Question: Express in one sentence what the figure is showing.
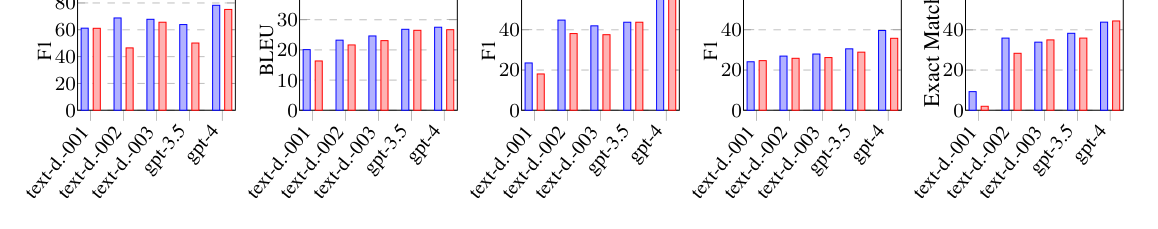
Answer: shows the results of our experiments on models of varying capability, from text-davinci- 001, -002, -003, to GPT-3.5 and GPT-4. Over- all, AMRCOT hurts performance for most tasks and models, again with Text-to-SQL being the ex- ception, at least for text-davinci-003 and GPT-4. In some cases, less capable models degrade more when using AMR, which might be due to their limited ability to comprehend AMR and reason over its special symbols. This is consistent with our preliminary observations that none of the non– instruction-tuned earlier GPT models, or the less capable models such as LLaMa and Alpaca, com- prehend AMR or reason over them well.